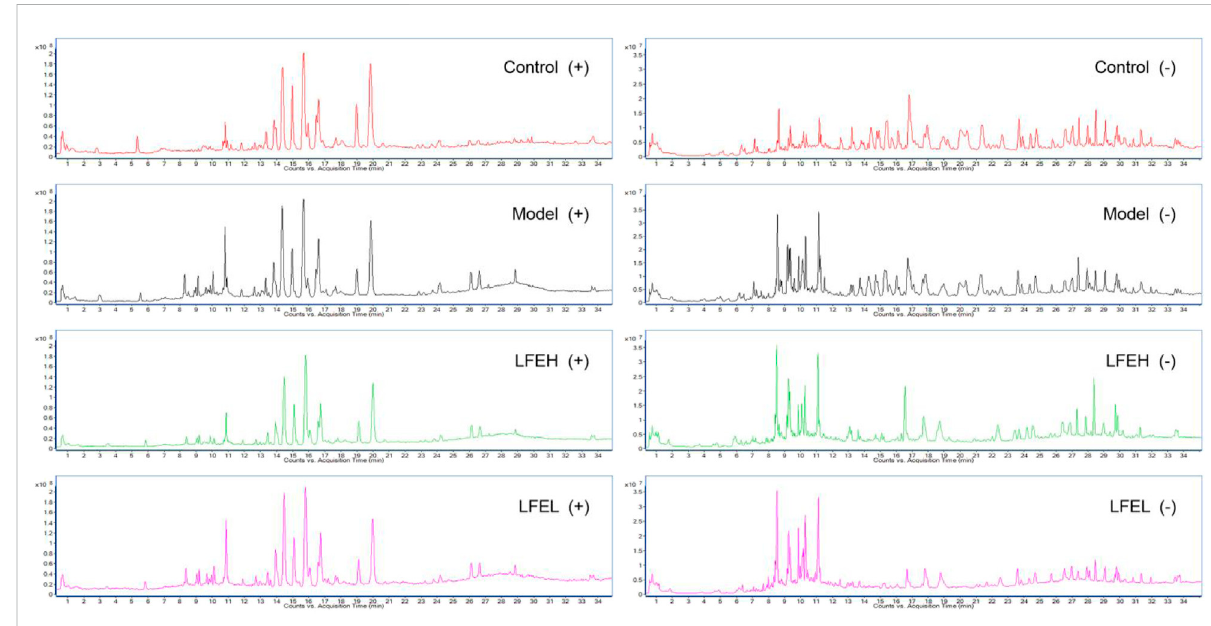
FIGURE 5 Metabolicpro fi leofeachgroupinpositiveandnegativemodes.Control,theblankgroup;Model,themodelgroup;LFEH,LFEhigh-dosegroup; LFEL, LFE low-dose